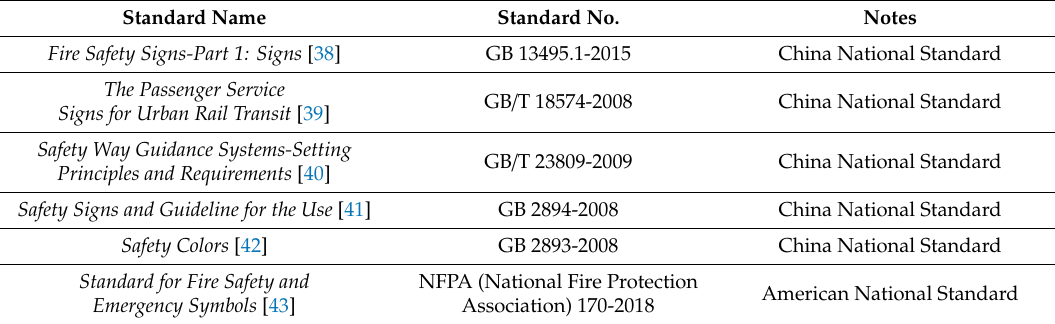
Table 1. The standards referenced in this